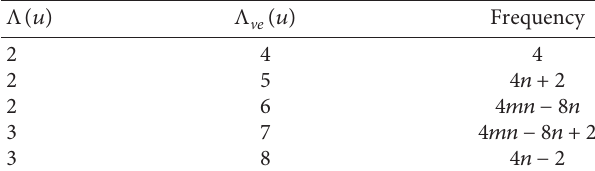
Table 2: The vertices’ ve-degrees of L [ m, n ]